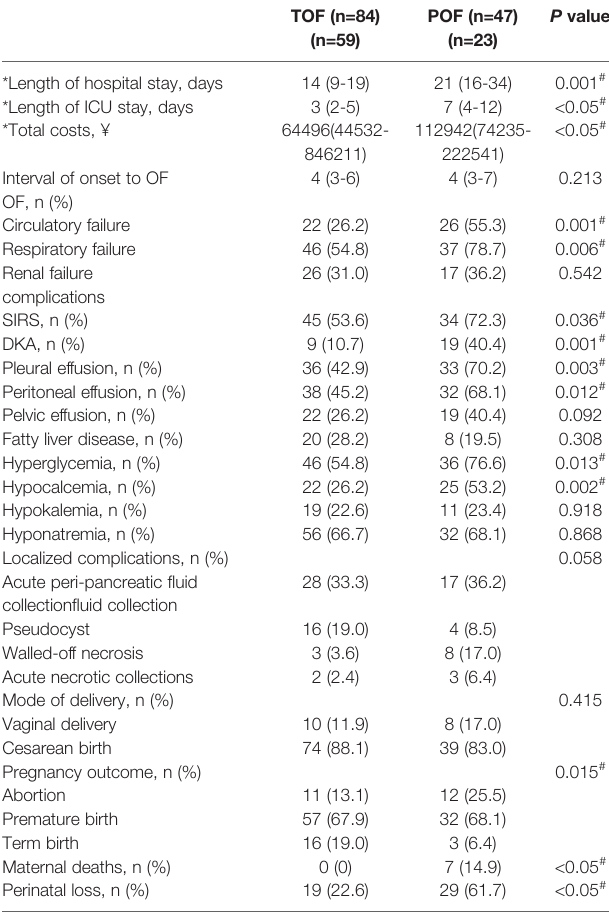
TABLE 2 | Comparison of the clinical course between POF and TOF groups.